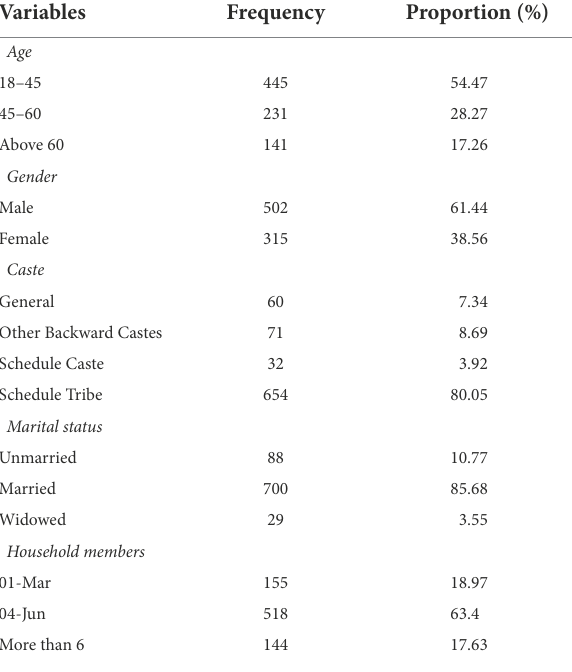
TABLE 1 Sociodemographic characteristics of study participants.